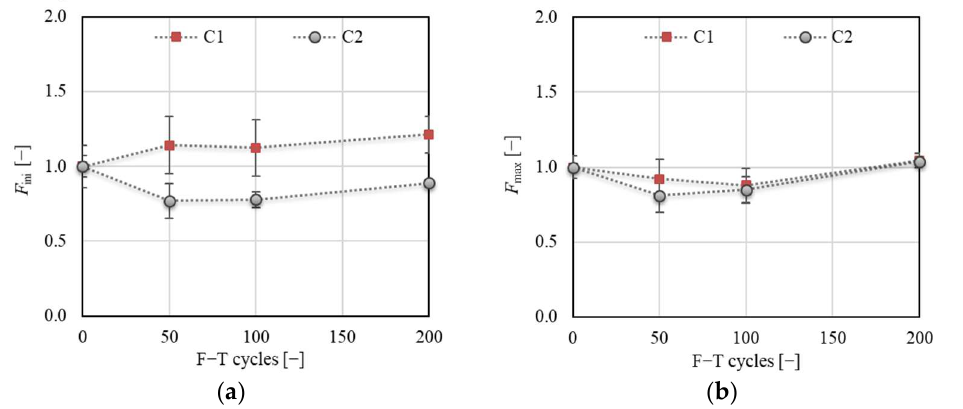
Figure 18. ( a ) Load level F ini ; ( b ) load level F max .